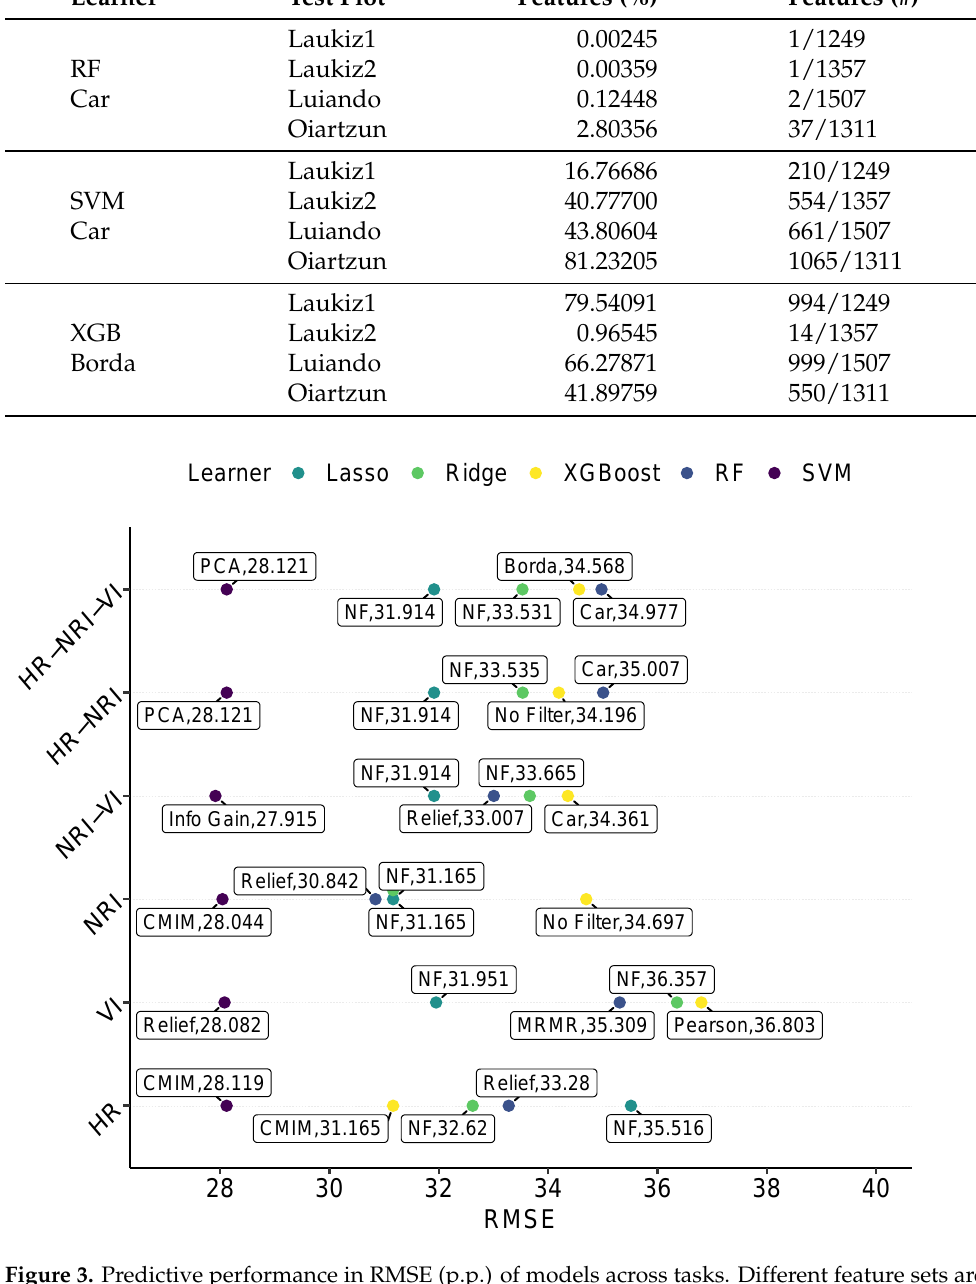
Figure 3. Predictive performance in RMSE (p.p.) of models across tasks. Different feature sets are shown on the y-axis. Labels show the feature selection method (e.g., NF = no filter, Car = “Carscore”, Info Gain = “Information Gain”, Borda =